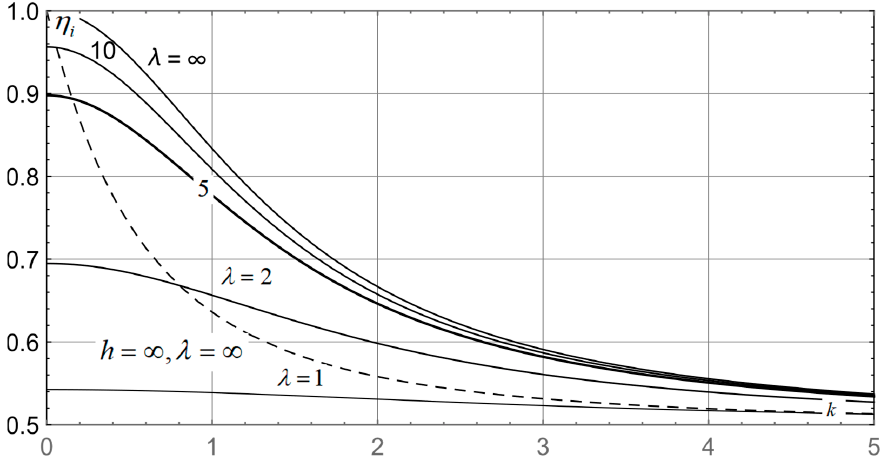
Figure 10. Ideal efficiency of a flat rectangular wing of different aspect ratio λ in heaving oscillations in extreme ground effect versus Strouhal number. Dashed is the efficiency curve for a heaving foil out of ground effect (Note that the efficiency of heaving foil out of ground effect for a flat plate shown in Figure 10 by dashed line was evaluated with use of classical formula η i = [ F 2 ( k /2 ]+ G 2 ( k /2 ) / F ( k /2 ) , 2 where F and G are real and imaginary parts of Theodorsen function [1]).